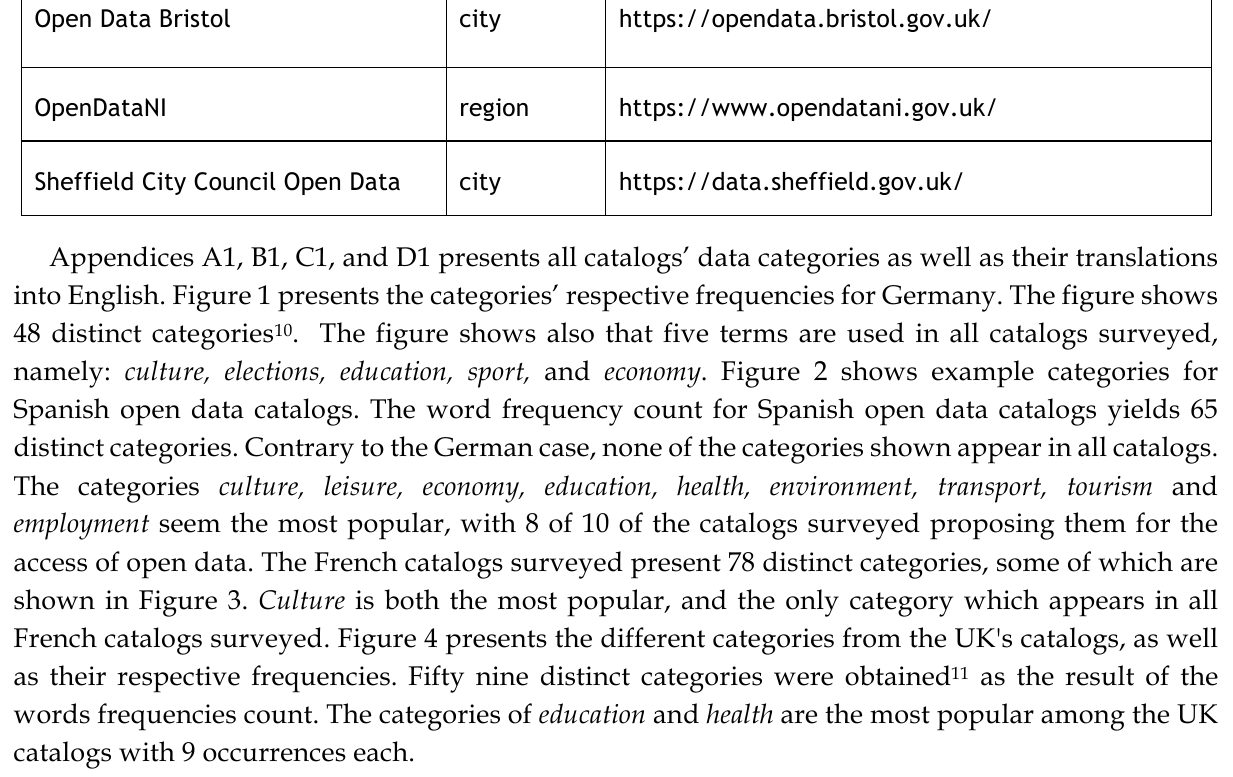
Figure 1: Categories of German Open Data Catalogs and their